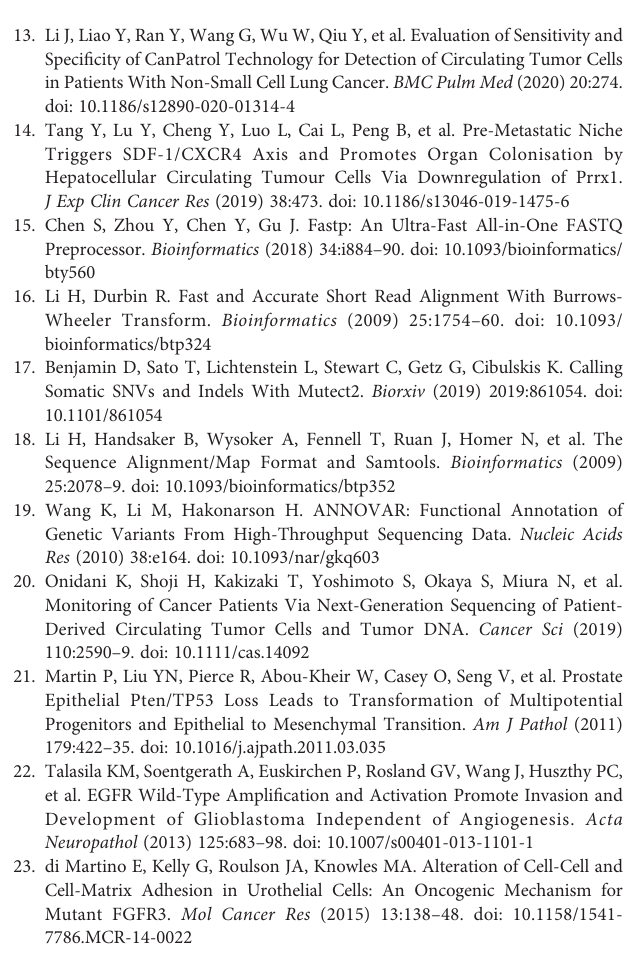
Supplementary Figure 1 | (A, B) Case vignette monitoring the genomic alterations in circulating tumor cells and mesenchymal CTC and CTC-WBC cluster